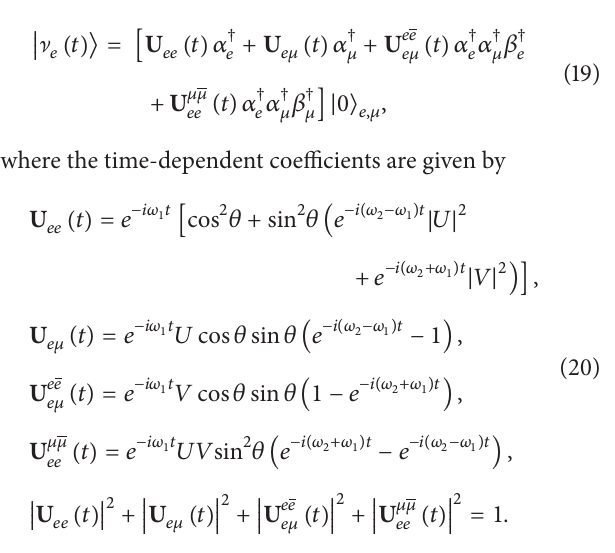
(full line) and 𝐶 ( ] 𝑒 ; ] 𝜇 ) (dashed line) as functions of the scaled time −𝜔 )𝑡 . The mixing angle 𝜃 is fixed at the experimental value 𝜏 = (𝜔 2 1 sin 2 𝜃 = 0.314 ; the parameters 𝑥 and 𝑝 are fixed as 𝑥 = 10 and 𝑝 = 5 . The concurrence associated with the quantum-mechanical Pontecorvo states (dotted line), that is, Figure 1, is also reported for